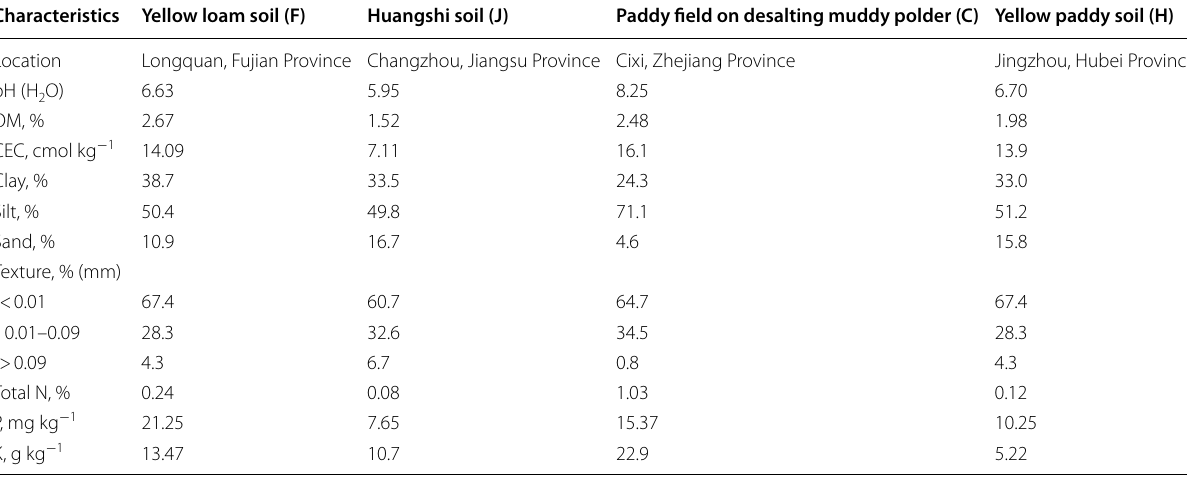
OM organic matter, CEC cation exchange capacity